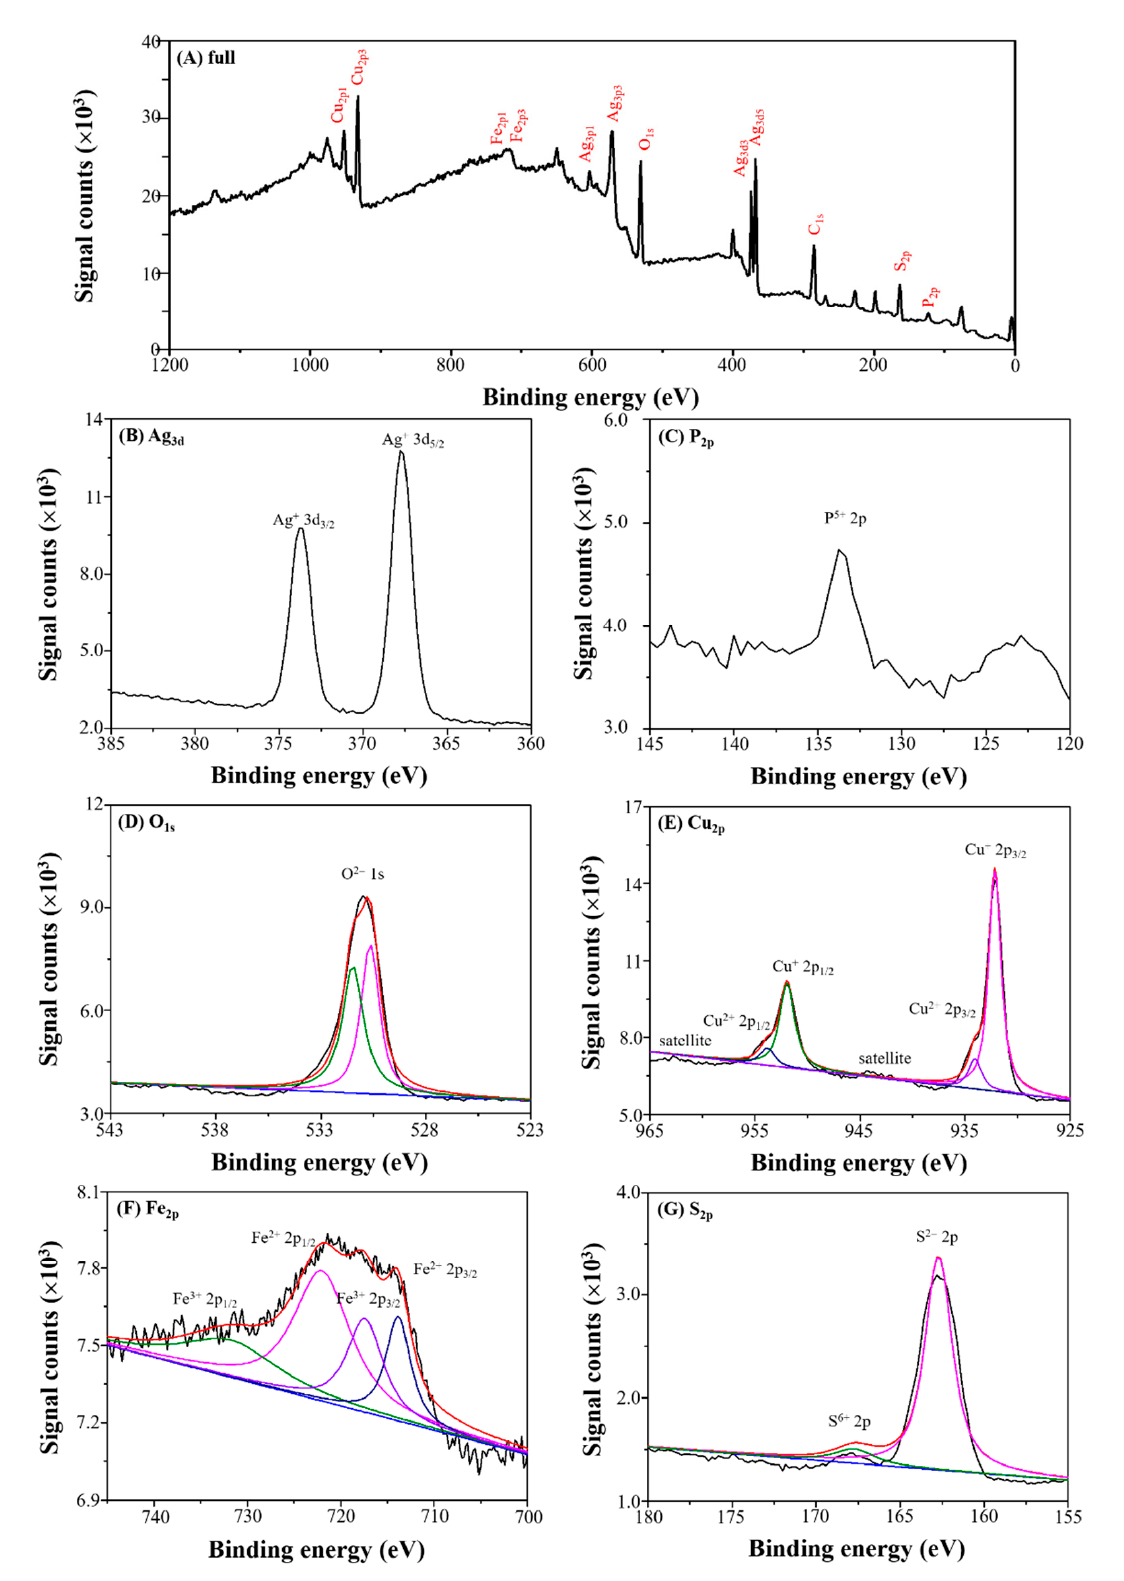
Figure 8. XPS spectra of CuFeS 2 / Ag 3 PO 4 : ( A ) full scan; ( B ) Ag 3d ; ( C ) P 2p ; ( D ) O 1s ; ( E ) Cu 2p; ( F ) Fe 2p ; and ( G ) S 2p . Deconvolution of XPS peaks for O 1s , Cu 2p , Fe 2p and S 2p elements represented in different color line.